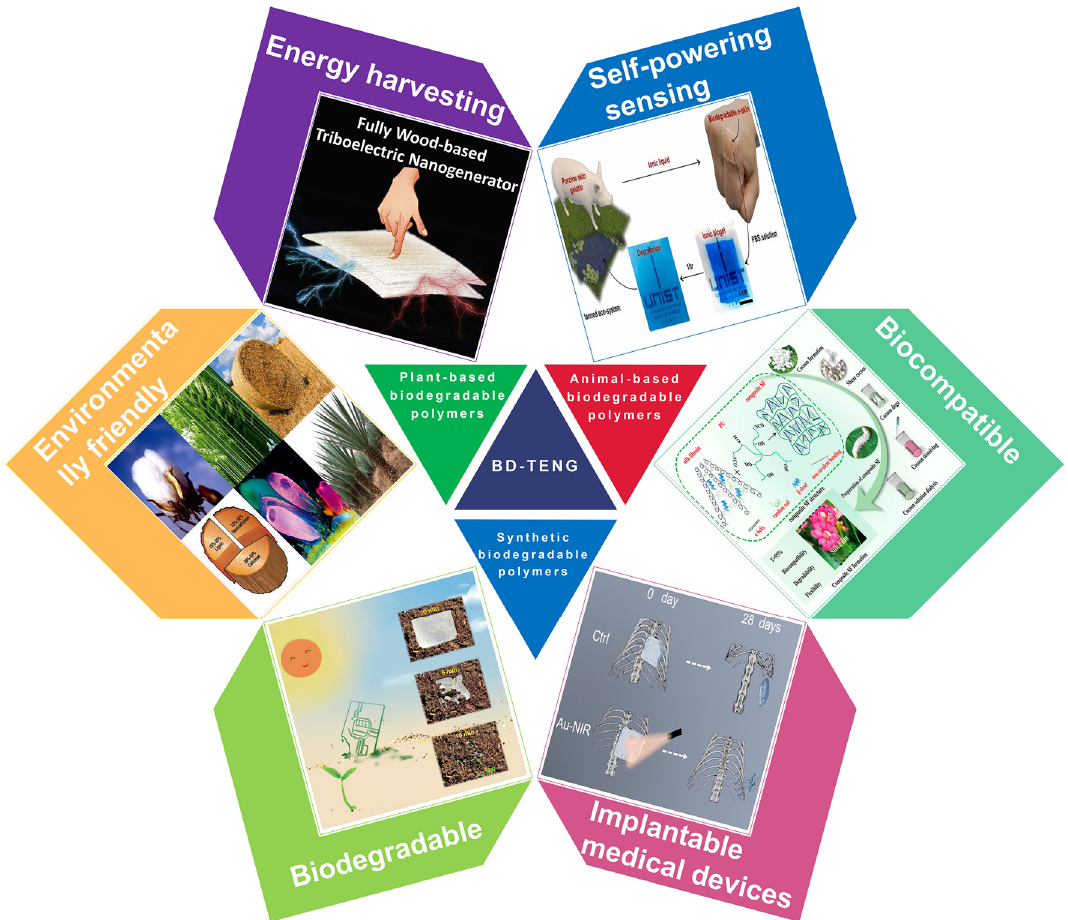
Figure 1. The schematic diagram shows the material sources (plant based, animal based, synthetic) and potential applications (energy collection, self-powered sensing, implantable medical devices) of BDPs proposed in this review in BD-TENG. BD-TENG needs to combine biodegradability, biocompatibility and environmental friendliness.